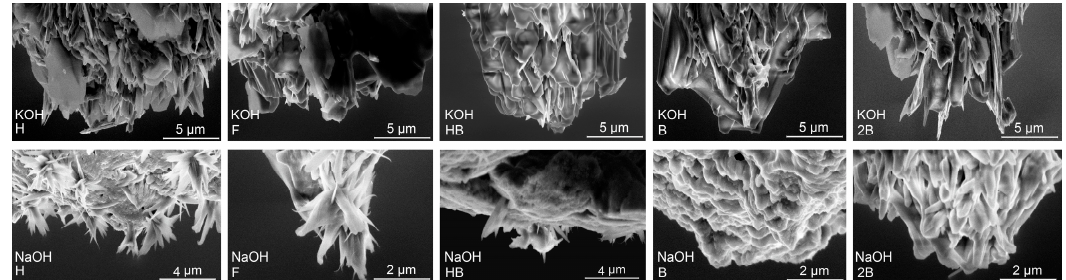
Figure 4. SEM image of the tips of various hardnesses (H, F, HB, B, and 2B) that were produced by electrochemical etching using KOH ( top row ) and NaOH ( bottom row ). The material used for these tips is Koh-i-Noor PG [22].